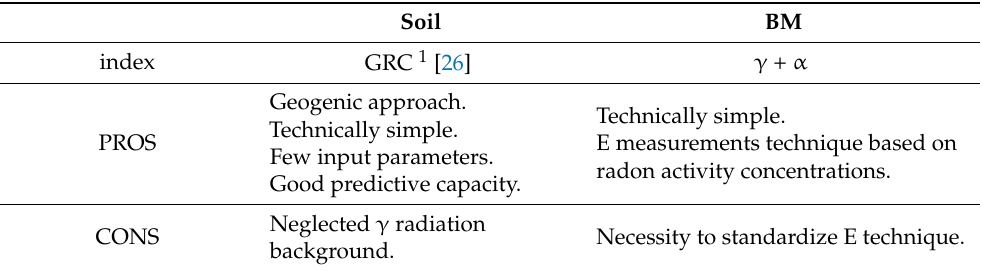
Table 3. Proposed indexes.